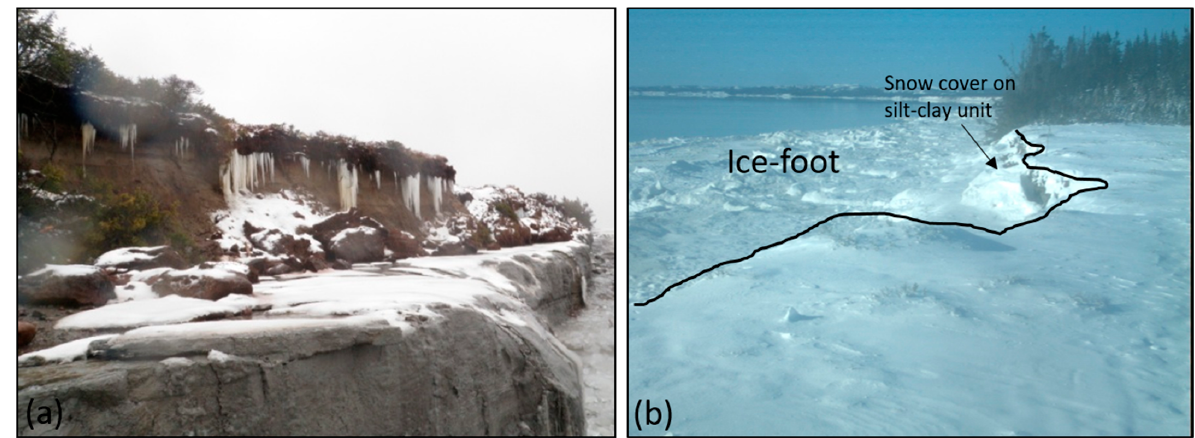
Figure 20. ( a ) Erosion of the sandy unit by wave sapping during a winter storm; ( b ) the surface of silt–clay unit is completely covered with snow, 18 January 2009. The black line corresponds to the top edge of the cliff.